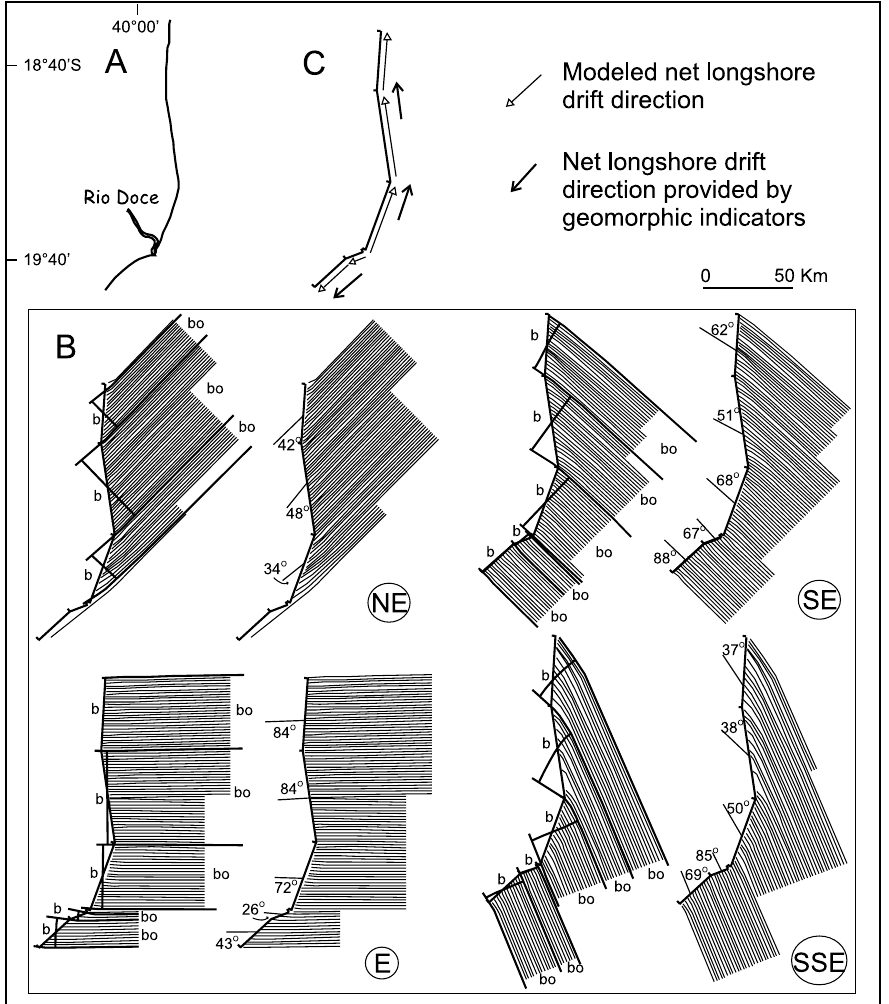
Fig. 2 – (A) Current coastline in the Doce River mouth. (B) Refraction diagrams for waves with a 5-s period, coming from NE and E, and 6,5-s period, coming from SE and SSE. Here are also shown: 1) different segments into which the shoreline was rectilinearized, 2) incidence angles formed by the wave-rays in relation to the coastal segments and 3) measurements of b and b o (see text) used to estimate wave height along the shore segments. (C) Rectilinearized shoreline showing the directions of net longshore drift of sediments estimated from numerical modeling and from geomorphic